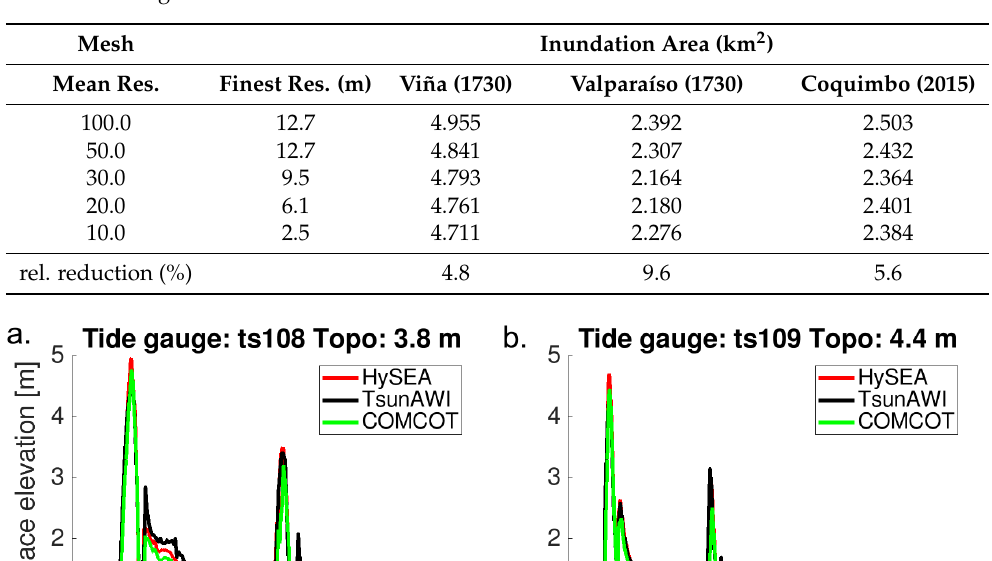
Table 8. Inundation area in pilot regions (refer to a minimum flow depth of 1 cm) obtained by TsunAWI in all meshes. The relative reduction is obtained by computing the ratio of the difference between the largest and the smallest value with reference to the maximum.